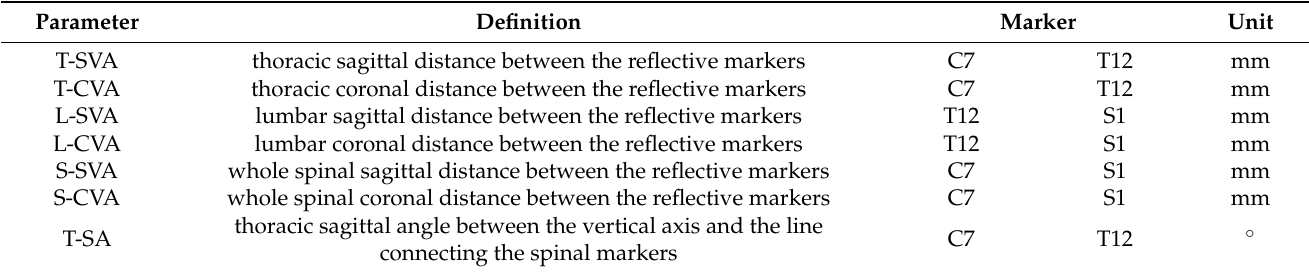
Table 1. Dynamic spinal alignment parameters.